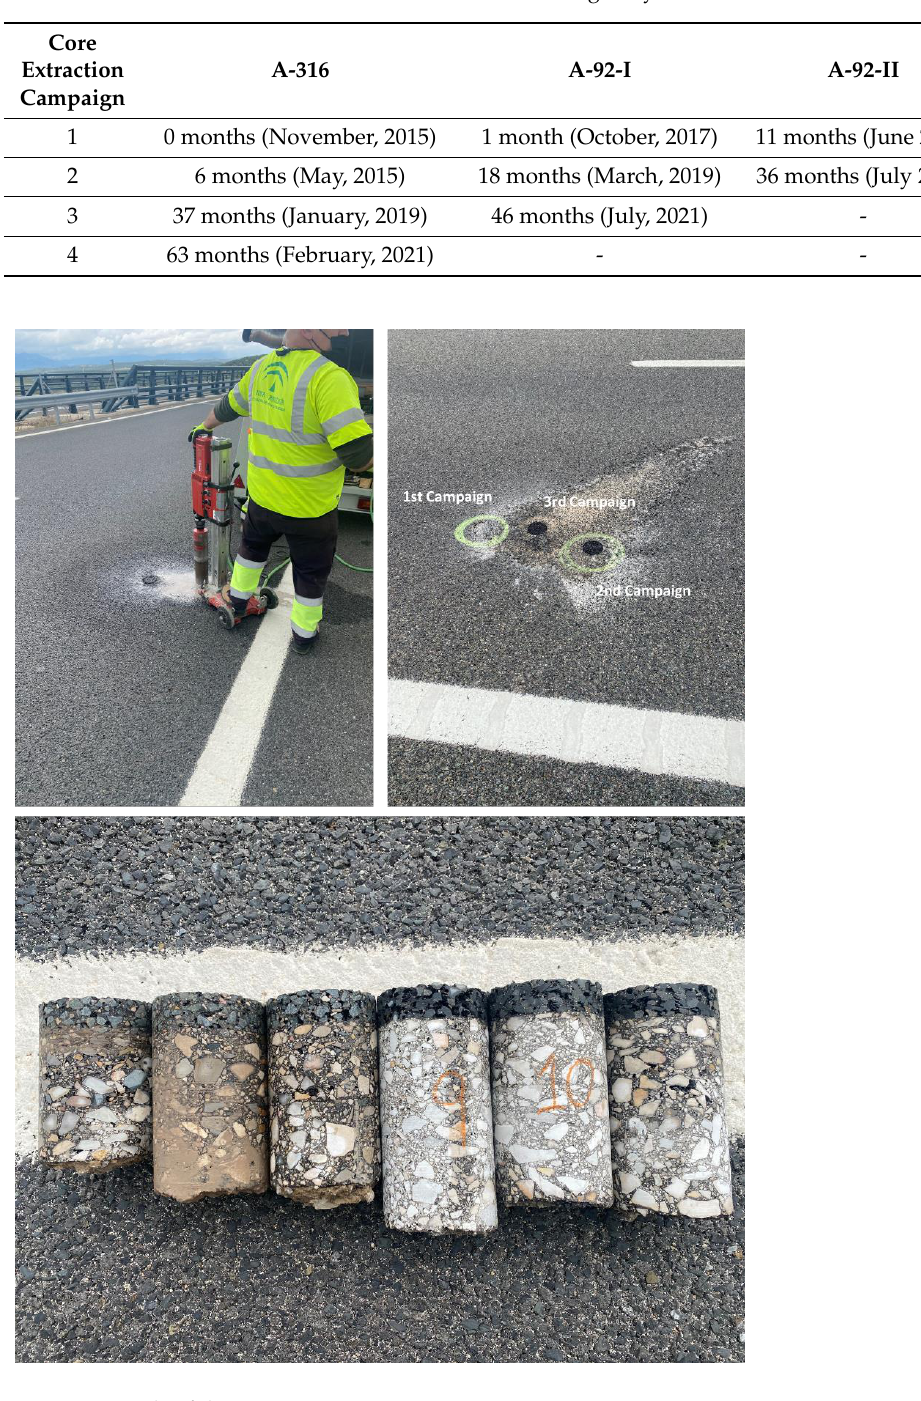
Figure 2. Details of the core extraction process.